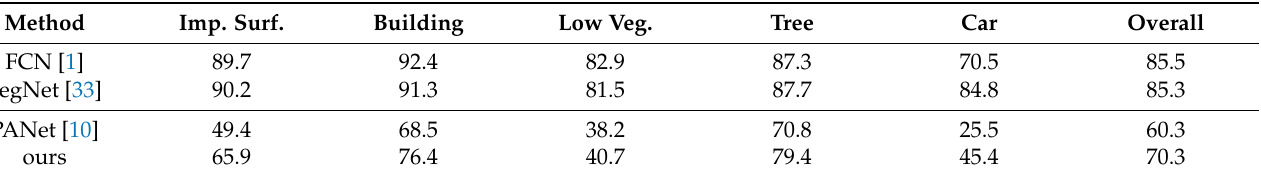
Table 4. F1 score of each class, and the overall accuracy using Vaihingen dataset (comparison between deep learning and few-shot learning of segmentation